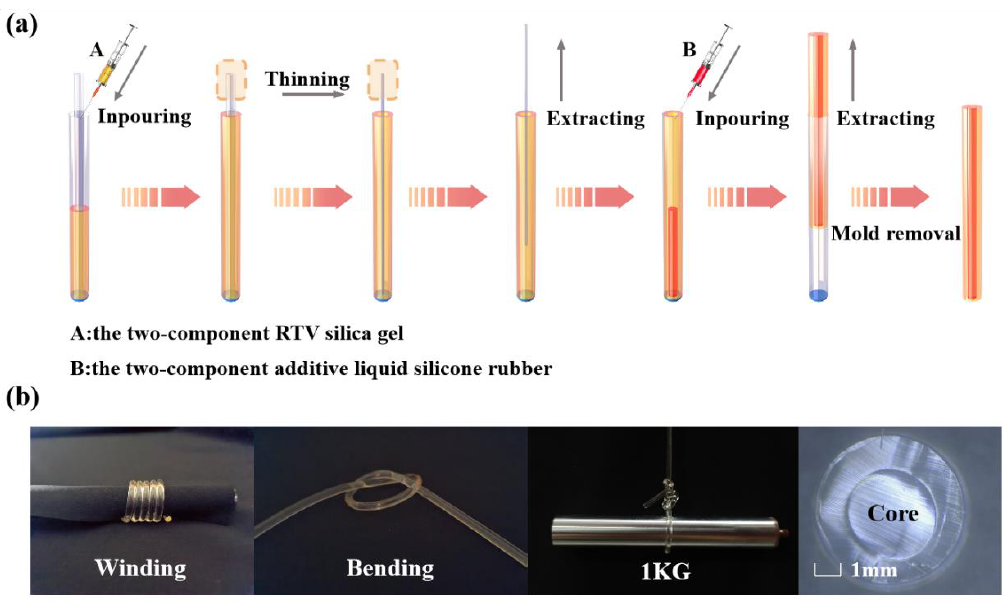
Figure 2. ( a ) Manufacturing process of elastic fiber. ( b ) The state of elastic fiber under winding and bending. And the cross-section of elastic fiber.